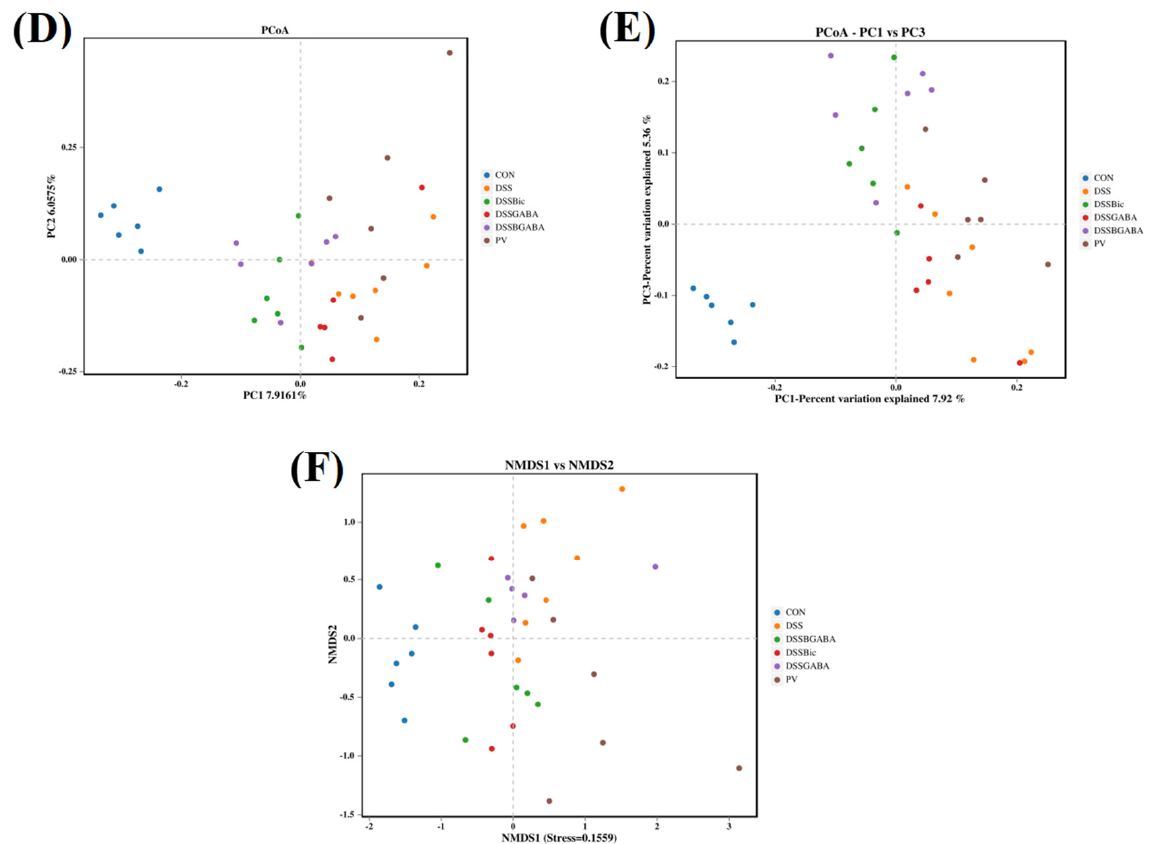
Figure 6. Diversity indexes of microbiota in the mice colon. ( A ) Venn diagram of identified OTUs. ( B , C ) α− diversity analyzed by Chao1 and Shannon indices. ( D – F ) β− diversity analysis of gut microbiota of each group.